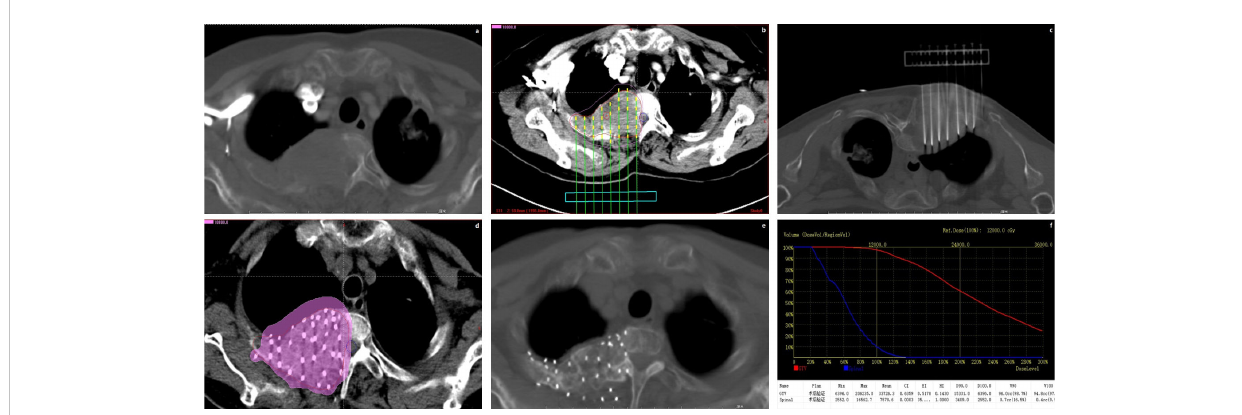
FIGURE 1 Represent CT scan of a patient during the whole treatment process. (A) Preoparative image. (B) Preoparative plan. (C) Operation process. (D) Postoperative Dosimetry Evaluation. (E) Twelve months after 125 I seed implantation. (F) Postoperative Dose Volume